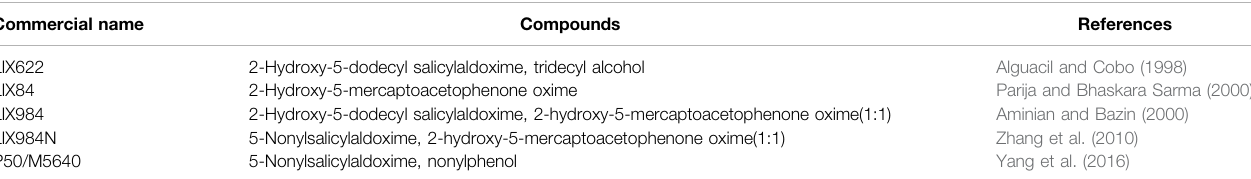
TABLE 1 | Alkyl salicylaldoxime investigated by some previous